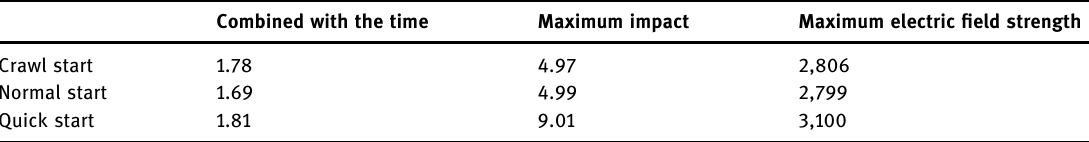
Table 3: Comparison of simulation results of clutch combination process under three working conditions Combined with the